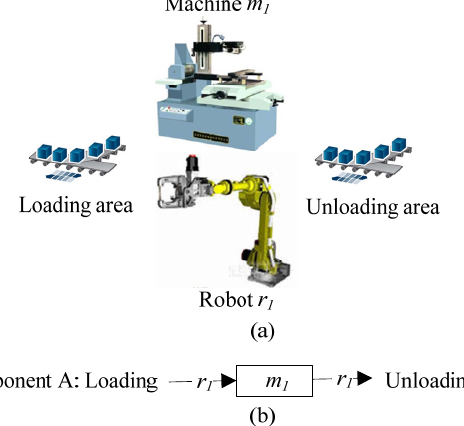
Figure 2. ( a ) Example of an AMS and ( b ) its processing route.